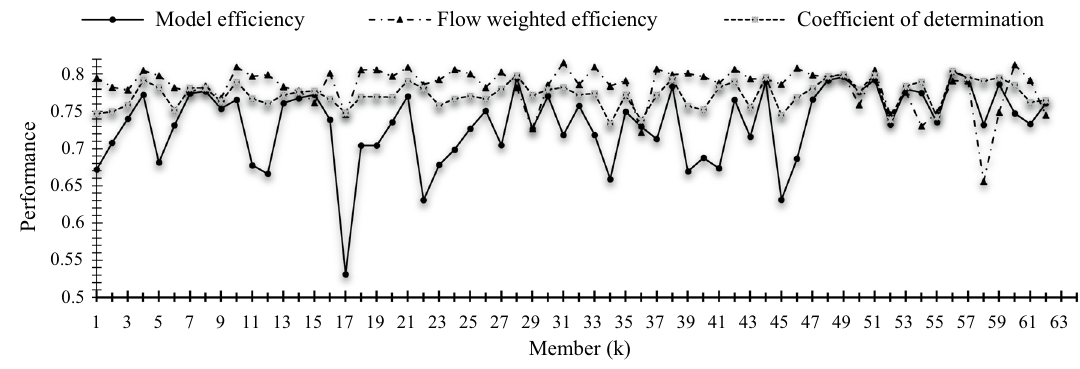
Fig. 7 Variation of the model performances with different members of forecasted rainfall Fig. 8. Exploratory analysis of this figure gives an overview on the representativeness of the daily ensemble flow dis- charges forecasts upper the Manantali dam. The ensemble is assumed to be of good representativeness with reference to ensemble evolution in Bartholmes et al. (2005) and also in Quilty et al. 2019. This analysis allows assuming without assessment of the statistic verifications the skillfulness of the hydrological ensemble forecasting system.